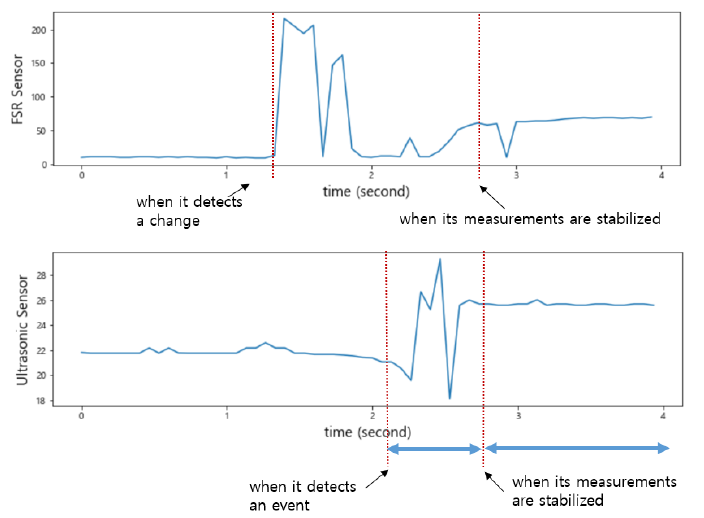
Figure 8. The sections for the FSR sensor and the ultrasonic sensor when putting in an item.